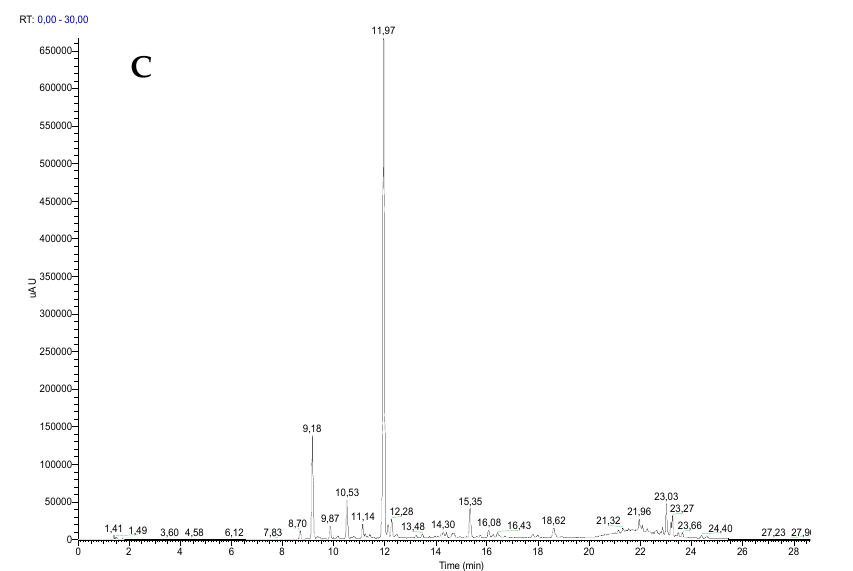
Figure 6. UHPLC chromatograms of G. tridentata extracts. ( A ) Stems extract (S) recorded at 230 nm; ( B ) leaves extract (L) recorded at 240 nm; ( C ) roots extract (R) recorded at 280 nm.